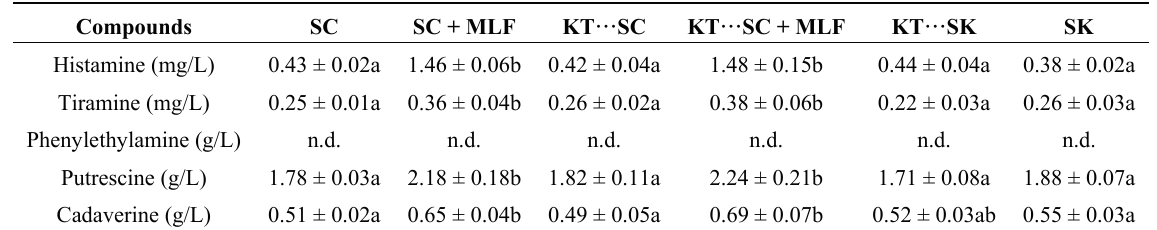
Table 2. Biogenic amines analysis of Saccharomyces cerevisiae 87 by itself (SC), sequential fermentation with Saccharomyces cerevisiae 87 and Kluyveromyces thermotolerans CONCERTO™ (KT···SC), sequential fermentation with Schizosaccharomyces pombe V2 and Kluyveromyces thermotolerans CONCERTO™ (KT…SK), Schizosaccharomyces pombe V2 by itself (SK), and fermentations after malolactic fermentation with